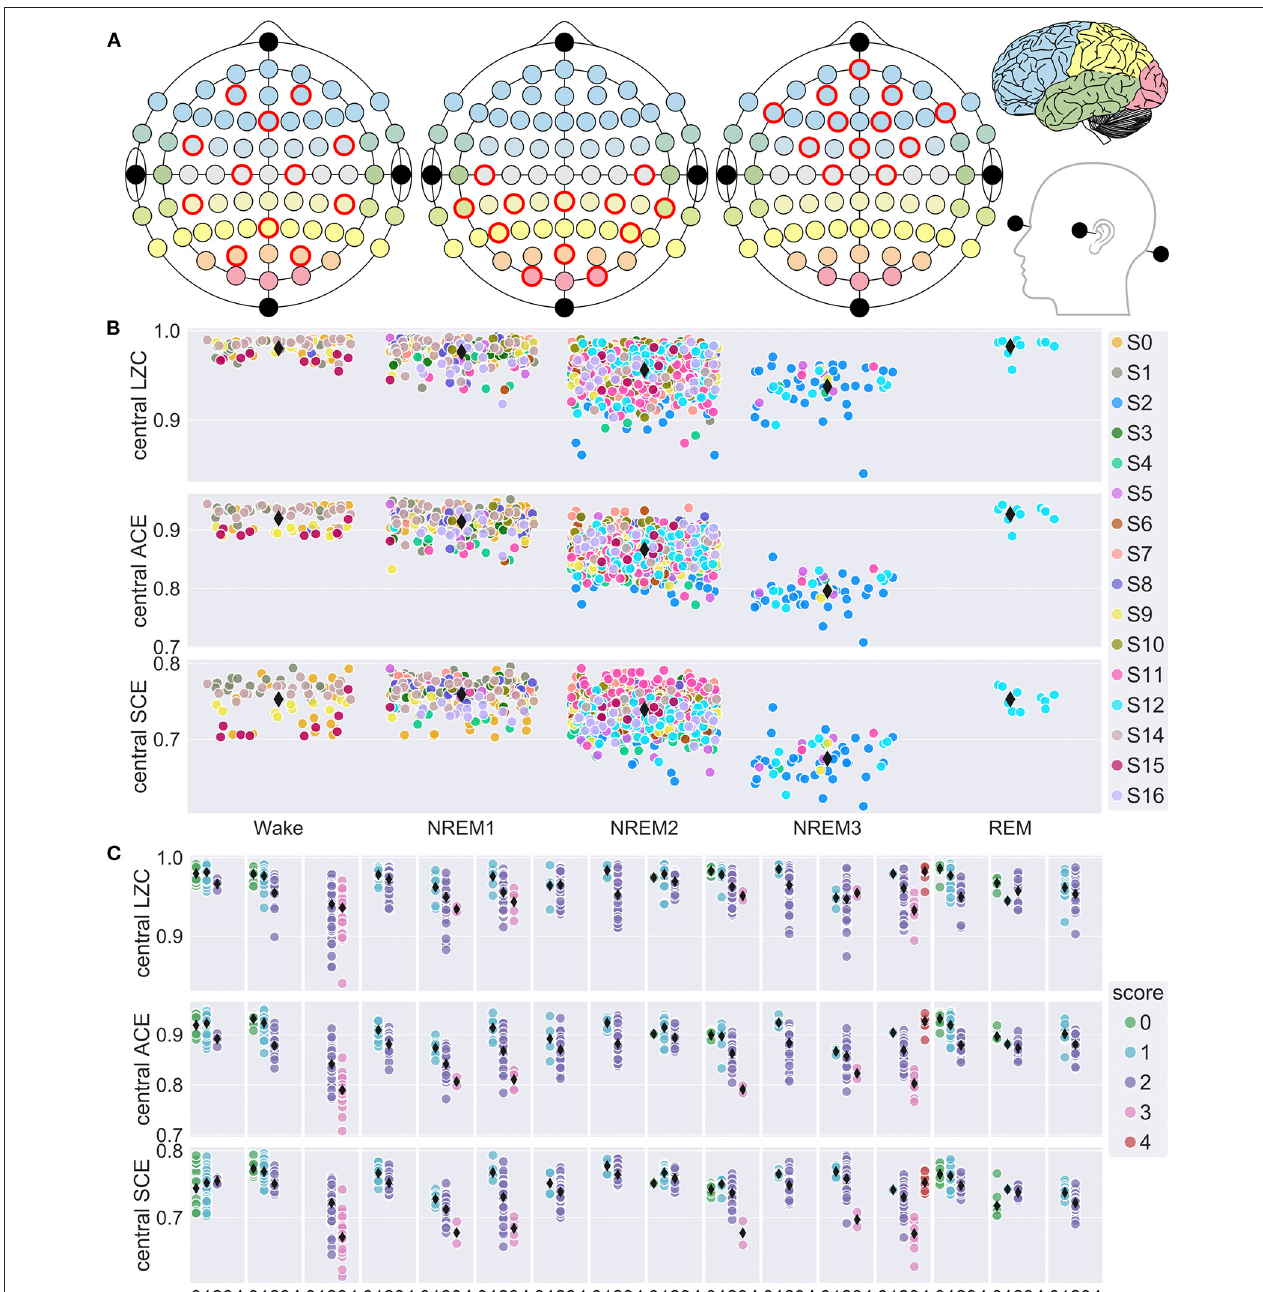
FIGURE 1 | EEG channel selection and variation in signal diversity with sleep stage. (A) Central, posterior and frontal channel selections. Electrode fill color indicates associated cortical lobe [adapted from illustration by Laurens R. Krol, distributed under a CC0 1.0 license (Krol, 2020)]. (B) Mean LZC, ACE and SCE for all 30s sleep epochs vs. sleep stage for the central channel selection. Observations are randomly jittered along x-axis to reduce overlap, and participant number (S0, …, S16) is indicated by marker fill color. Grand mean values for each sleep stage is indicated by black diamond markers. Most of the data is from NREM2 sleep, because we prioritized the within-state analysis of dream-reports from NREM2. In particular, all REM sleep epochs are from a single sleep trial for Participant 12. (C) Mean central LZC, ACE and SCE for the 30s sleep epochs vs. sleep stage (0 = W, 1 = NREM1, 2 = NREM2, 3 = NREM3, 4 = REM), plotted separately for each study participant (S0, …, S16). Fill color indicates sleep stage, and diamond markers indicates participant mean values for each stage.